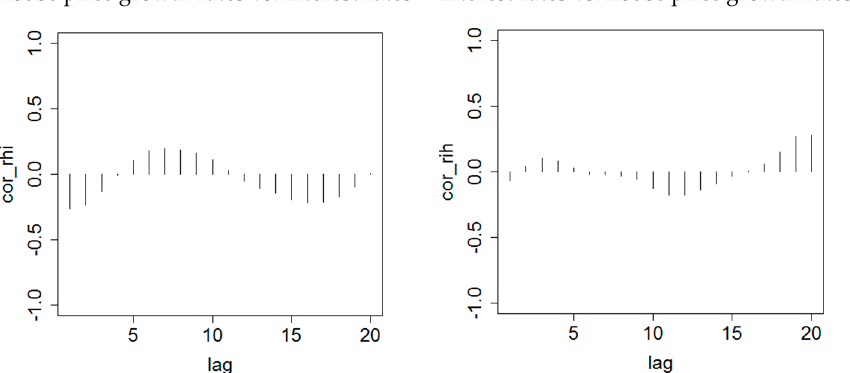
Figure 5. Sample autocorrelations and cross-correlations of house price growth rates and interest rates.